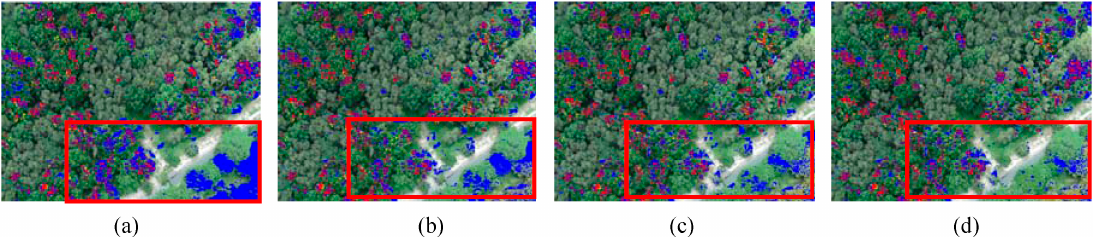
Figure 23. Resulting images of the region where a false alarm is likely to occur in Region 2: ( a ) Traditional CEM; ( b ) Subset CEM; ( c ) SW CEM; and, ( d ) ASW CEM.